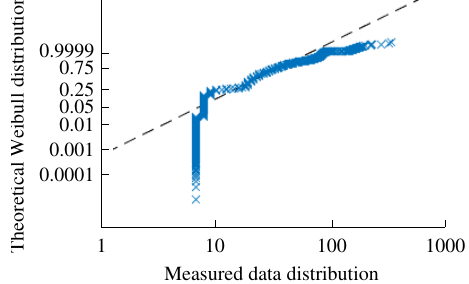
Figure 9. Probability plot for the Weibull (31.7,1.64)